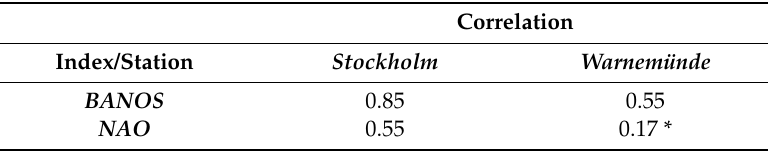
Table 2. Correlation coefficients between atmospheric indices and tide gauges are represented for the period 1900–2013 in wintertime. Notably, time series are detrended prior to the correlation computation. * The correlation between the North Atlantic Oscillation (NAO) index and the Warnemünde station is insignificant at the two-sided 95% confidence level.